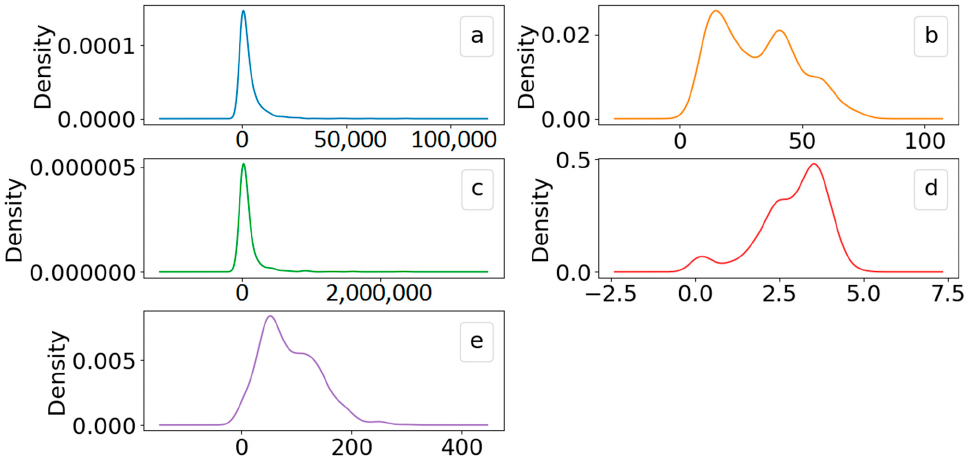
Figure 6. Density distribution using data of the top 10 affected states: ( a ) observed outage duration, ( b ) transformed outage duration, ( c ) total sales (USD millions) per minute, ( d ) total loss computed using transformed outage duration, and ( e ) total revenue loss computed using observed outage duration.